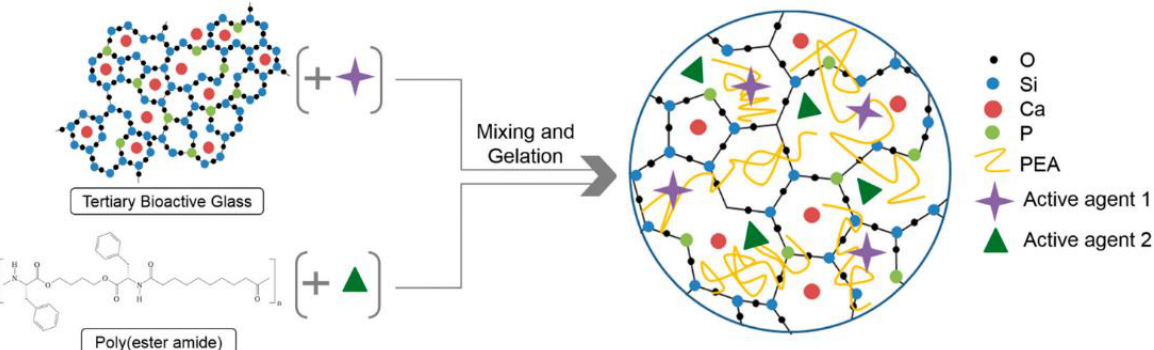
Figure 7. Schematic illustration of the two-stage synthesis approach of hybrid microparticles based on bioactive glass and poly(ester amide) (PEA). The singular components were mixed with an active agent. Subsequently the two mixtures were mixed together, and gelation was promoted, forming hybrid microparticles loaded with two different drugs. The figure is reproduced with permission from Intrinsically fluorescent bioactive glass-poly(ester amide) hybrid microparticles for dual drug delivery and bone repair by Aslankoohia and Mequanint et al., 2021, Materials Science and Engineering: C, 128, 112288 (doi:10.1016/j.msec.2021.112288). Copyright 2021 by Elsevier.